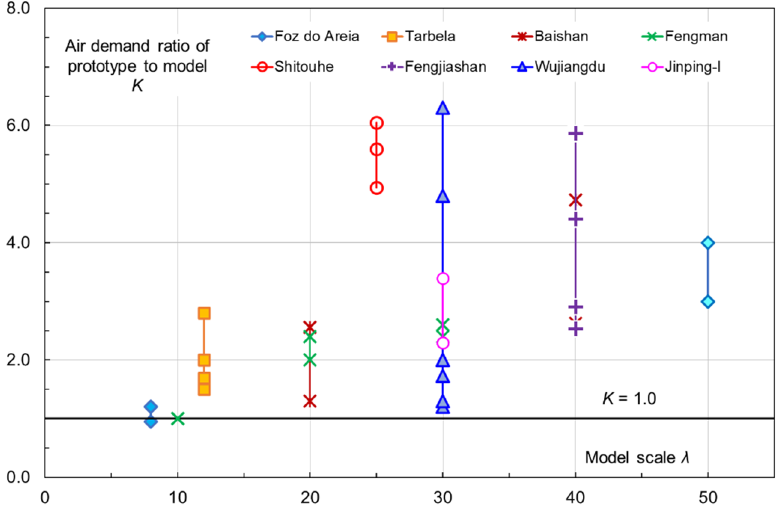
Figure 8. Comparisons of air flows between prototype and model, air demand ratio K based on model scales for eight spillway aerators (based on the data in [12,15]).